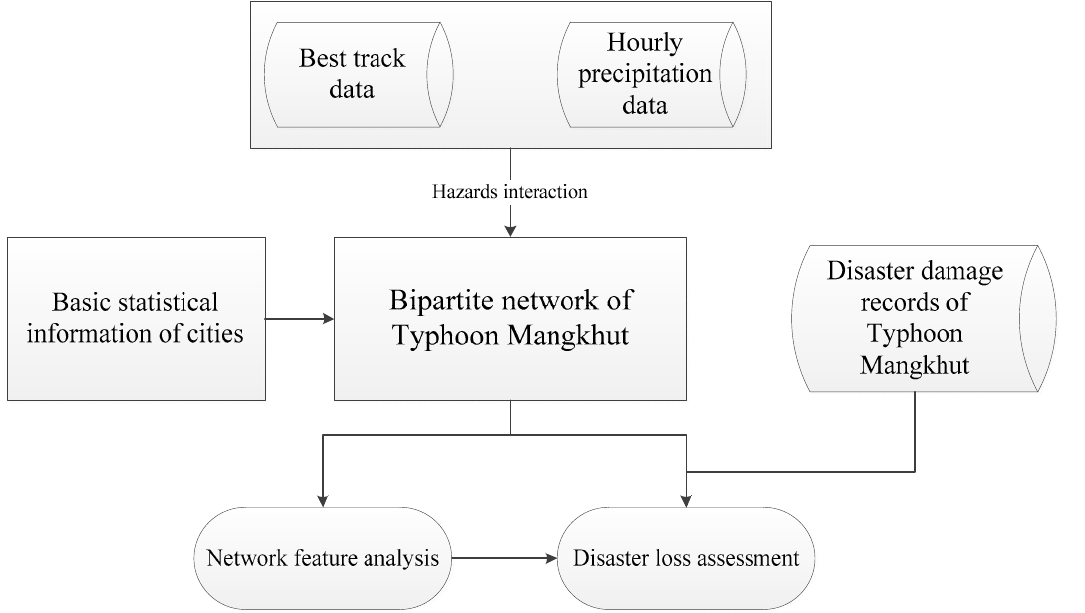
Figure 4. Flowchart of the disaster network construction in this study.